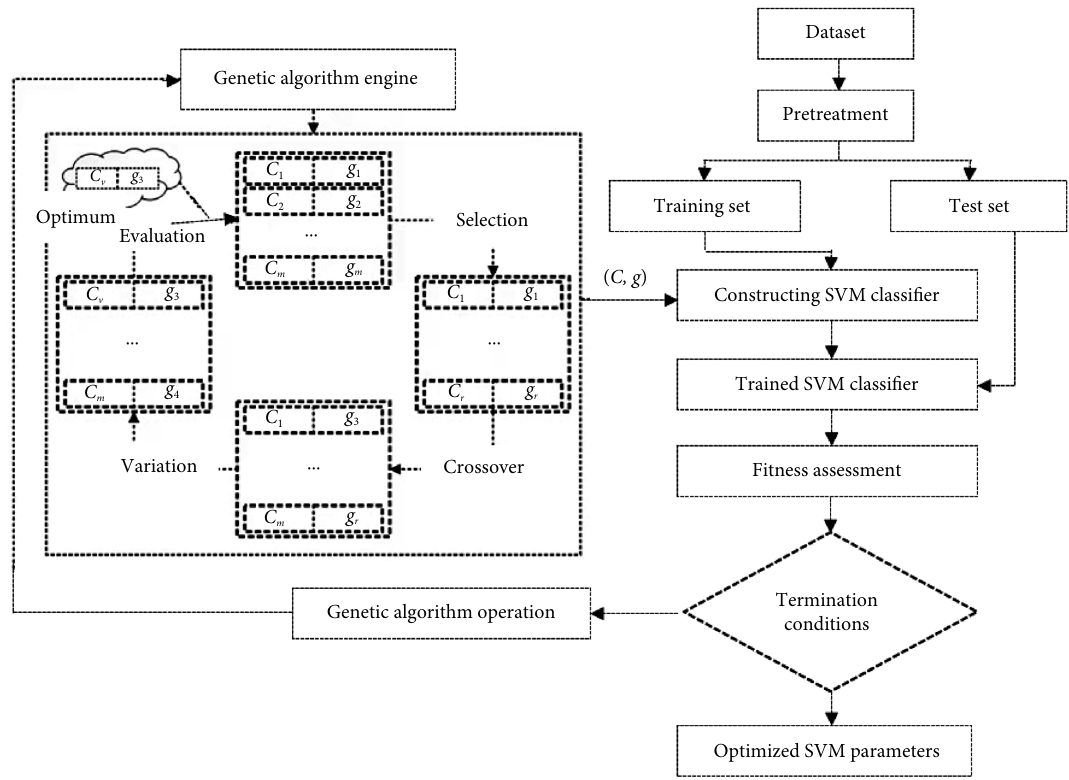
Fig. 9 GA-based system architecture for tuning SVM parameters.